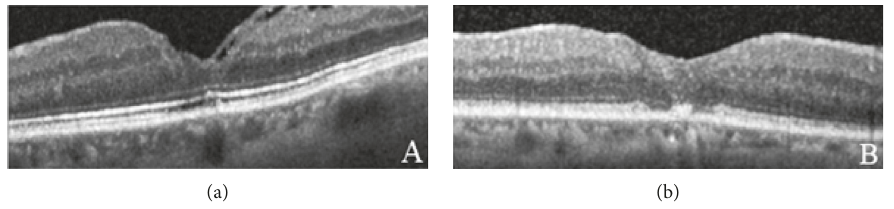
Figure 1: OCT with closed macular hole: integrity of ELM and EZ zone (a) and disrupt ELM and EZ